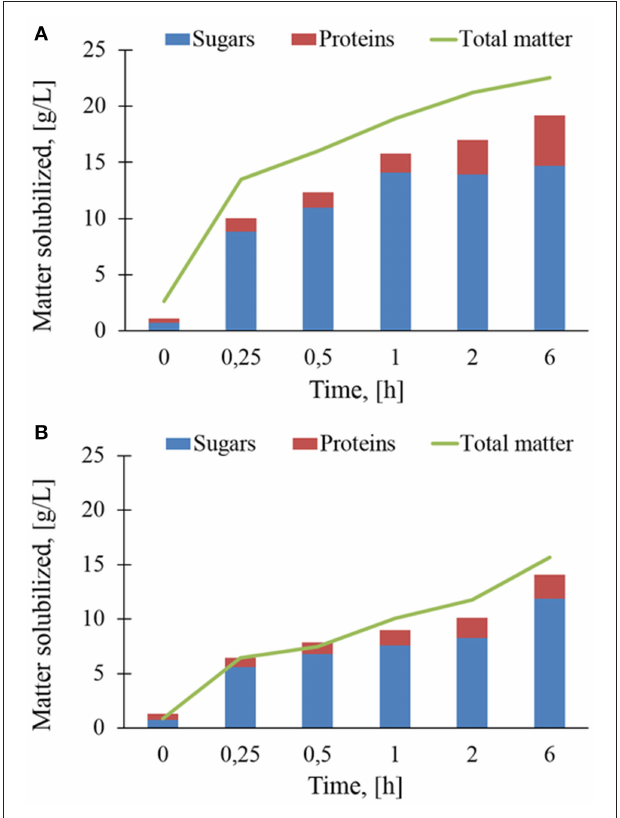
FIGURE 6 | Sugars, proteins, and total matter (g/L) solubilized during enzymatic treatment of the destarched wheat bran by Rovabio ® (A) and xylanase C (B) . Operating conditions identical to Figure 2 . Note that concentration is g of matter solubilized per liter of supernatant.